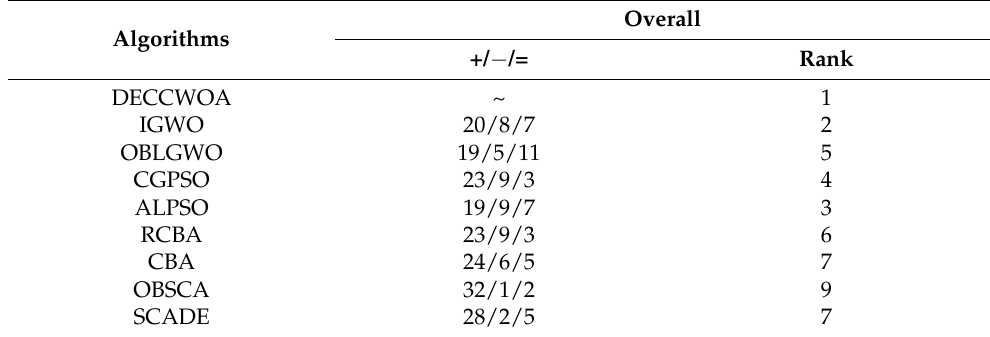
Figure 5. Convergence curves of comparison with improved WOA versions. Table 6. Comparison results for the DECCWOA and advanced